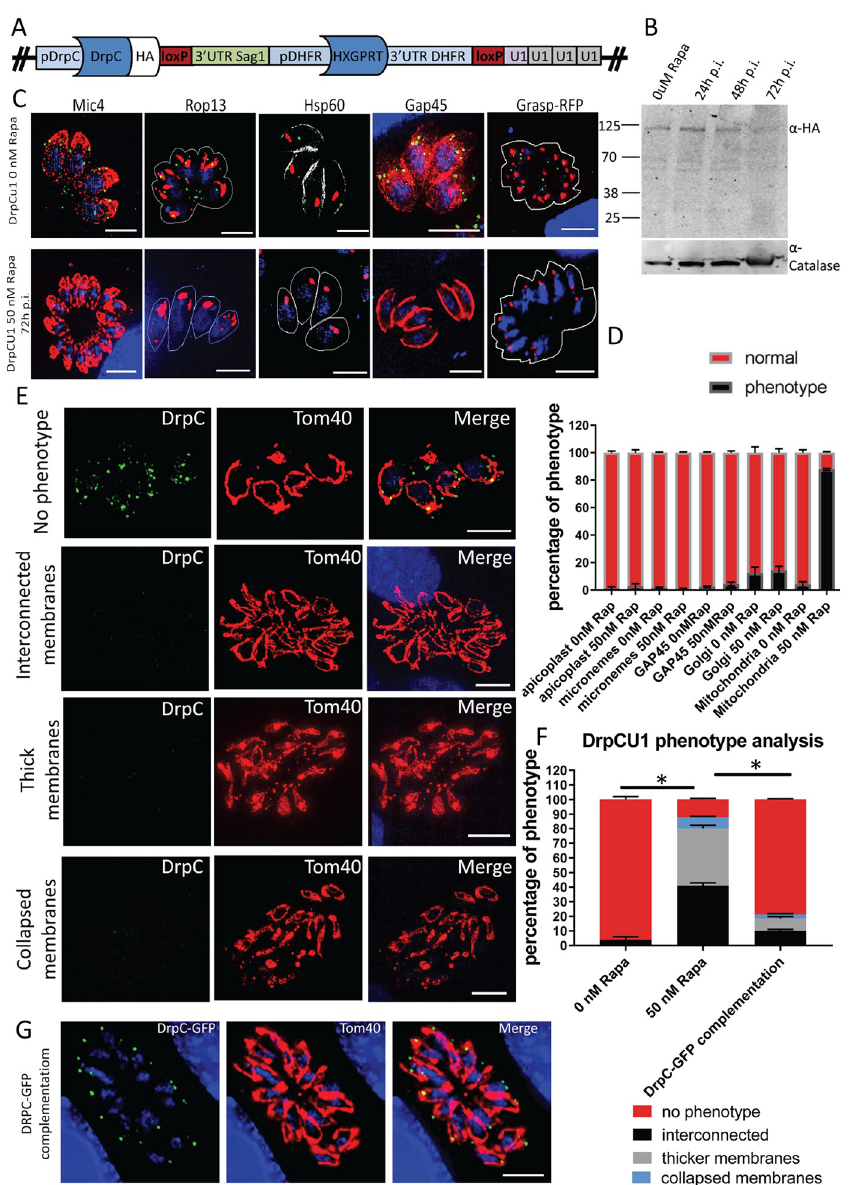
Fig 5. Inducible Knock-down of DrpC has a specific mitochondrial effect. (A) Scheme of the genomic locus after integration of the DrpC-U1 construct, as detailed in Pieperhoff et al., 2015. (B) Western Blot analysis showing efficient downregulation of Tg DrpC 72 hours post Rapamycin induction. The membrane was probed with α -HA and α - Catalase antibodies. (C) Immunofluorescence analysis shows that Tg DrpC signal is no longer observable at 72 hours post induction; at this time, the distribution of micronemes and rhoptries, probed with Mic4 and Rop13, was not affected in Rapamycin-treated parasites; similarly, the morphology of apicoplast ( α HSP60), IMC ( α GAP45) and Golgi (GRASP-RFP) appeared normal, as quantified in (D). (D) Organelle phenotypes were scored in the following way: for micronemes and rhoptries, an apical distribution was counted as “normal”; for the apicoplast, both location (at the apical part of resting parasites) and number (one per parasite in a vacuole) were assessed; for the Golgi, correct distribution above the nucleus and morphology (i.e., not fragmented) were checked; the IMC stain forming the “banana shape” typical of tachyzoites was scored as normal. For each data set, 100 parasitophorous vacuoles were counted. This was performed in triplicate. In contrast, as shown by Immunofluorescence analysis in (E) and quantified in (F), induced parasites showed severe morphology defects in the mitochondrion, classified as “interconnected mitochondria” (41%), “thick mitochondrial membranes” (39.2%) and “collapsed mitochondria” (7%) Scale bar: 5 μ m. (G) Complementation experiments through transient transfection of plasmid p5RT70-GFP-DrpC in Rapamycin- treated parasites led to rescue of the mitochondrial phenotype, as quantified in (F). Quantification in (F) was obtained